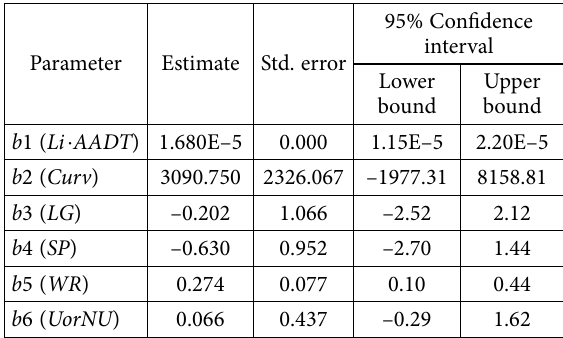
Table 4. Parameter estimates for the ‘non-linear model’